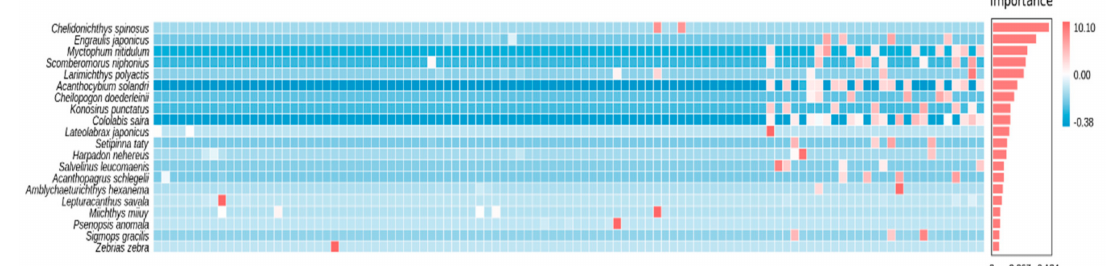
Figure 2. Importance according to the random forest analysis. From top to bottom, species become less important to the model; these species at the top of the list could be considered markers of intergroup di ff erences; the X-axes of the bar chart shows the importance of species to the classifier mode; the Y-axes shows the name of a taxon at the species